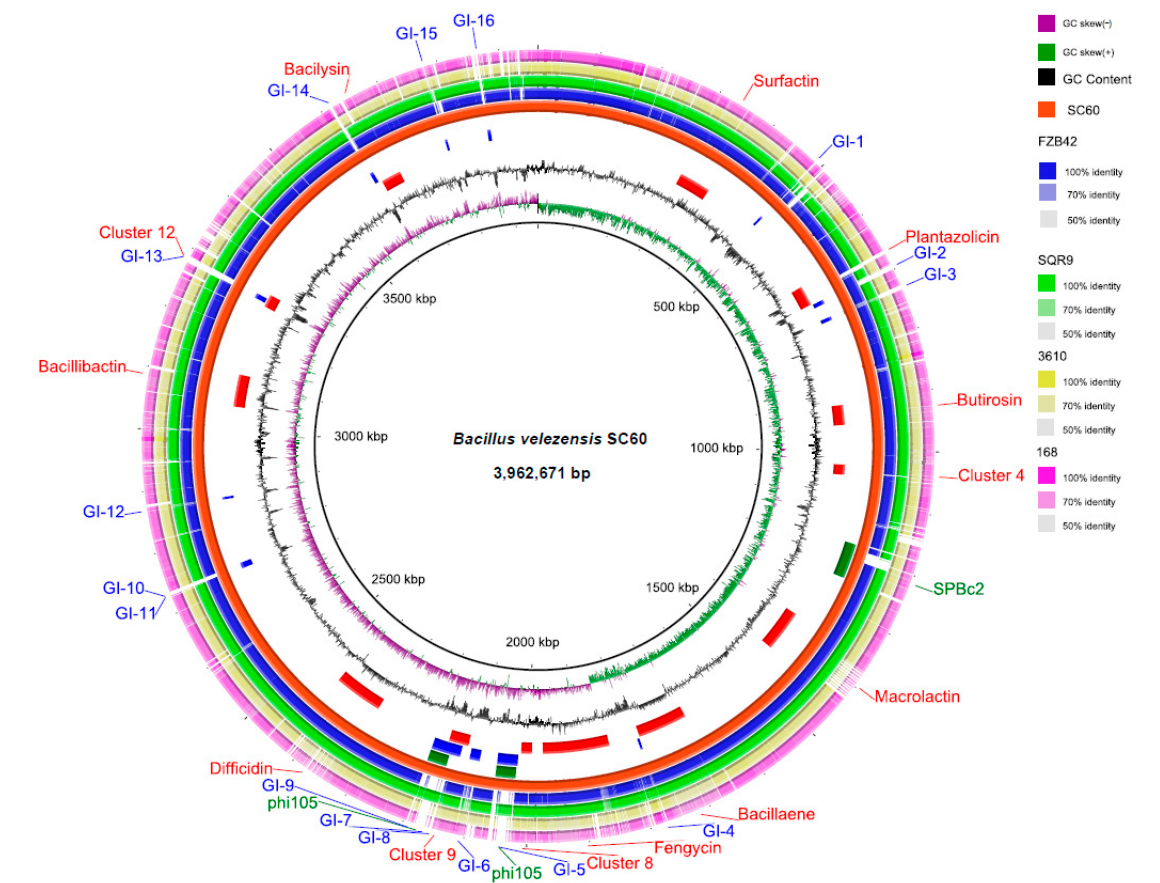
Figure 1. Whole genome features and comparative genome map of Bacillus velezensis SC60. Circle map displays from the inside to outside: (1) GC Skew, (2) GC Content, (3) secondary metabolite clusters, (4) gene islands, (5) predictive prophage clusters, (6) genome SC60, and (7, 8, 9, 10) blast comparison of the SC60 genome with Bacillus strains FZB42, SQR9, 3610, and 168, respectively. Map and comparative genomic analysis were performed with BRIG. Table 1. General genomic features of Bacillus velezensis SC60.